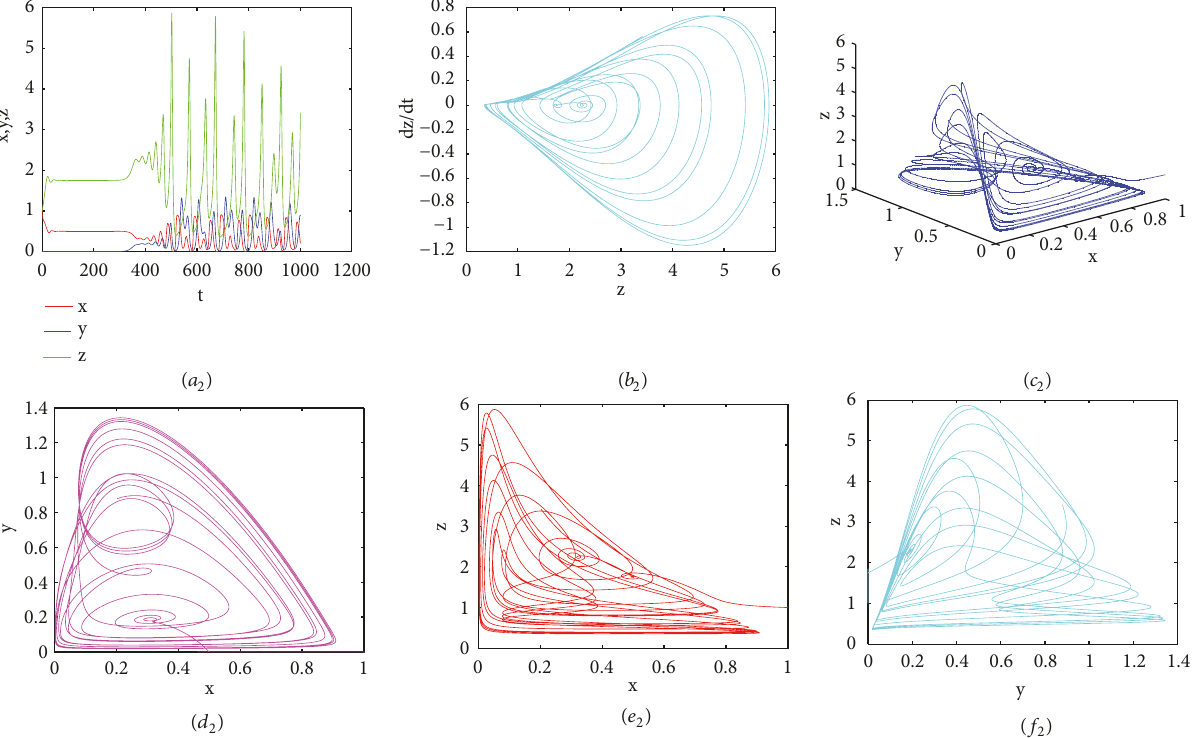
Figure 4: A tritrophic food web system for Experiment 2 with the initial condition (2) : (𝑎 2 ) time series plot of 𝑥, 𝑦,𝑧 ; (𝑏 2 ) phase diagram of 𝑧 ; (𝑐 ) on the three-dimensional space; (𝑑 2